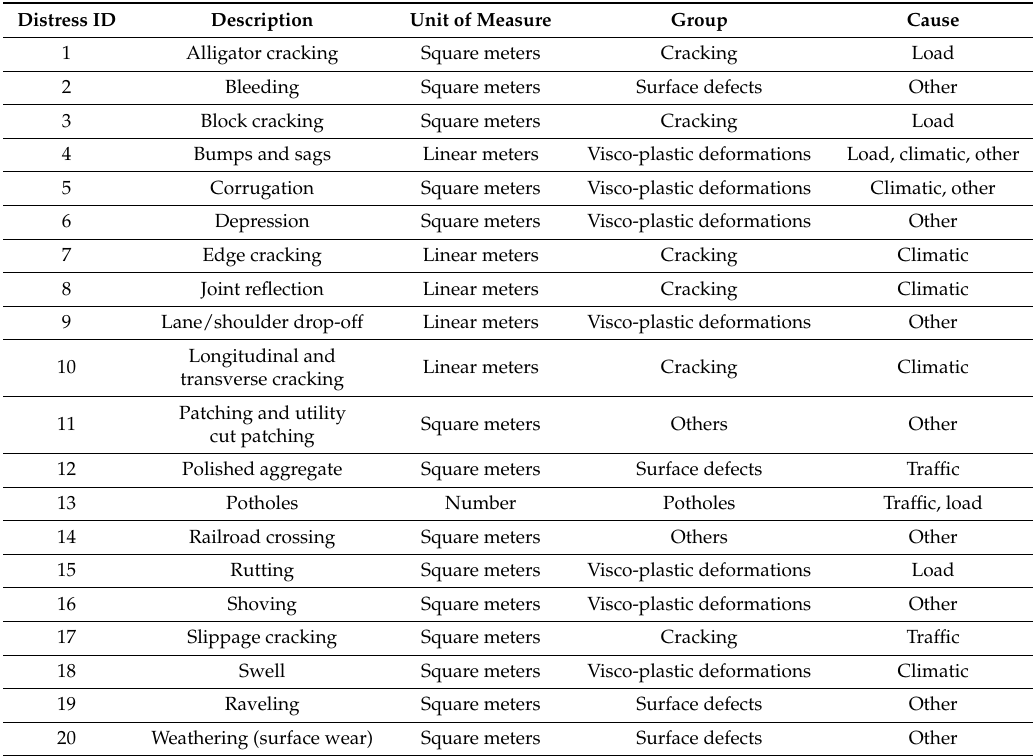
Table 1. American Society for Testing and Materials (ASTM) D6433 distress identification catalogue asphalt concrete list of